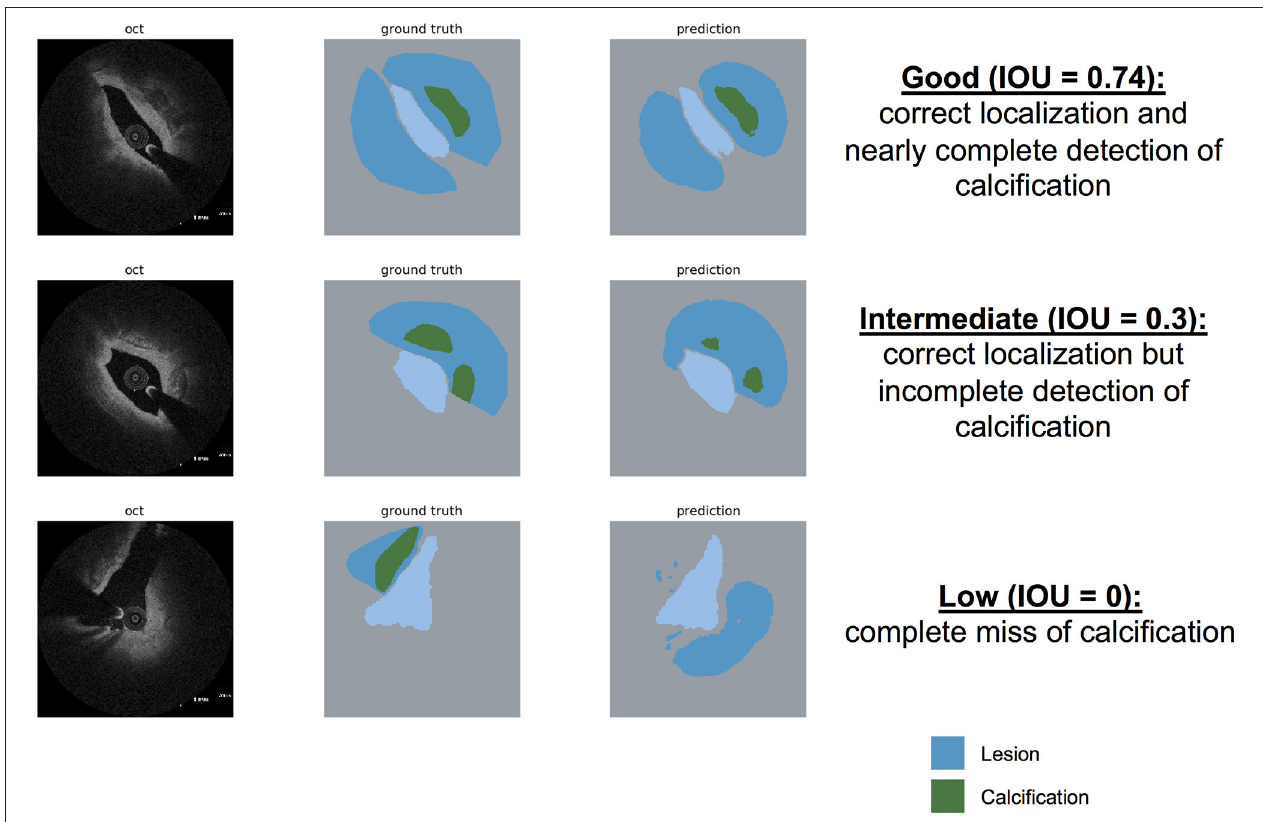
FIGURE 5 | Prediction of calcification by DeepAD. Examples for “good” (upper row) , “intermediate” (middle row) , and “low” (lower row) prediction of calcification using DeepAD (dark blue = lesion, green = calcification, light blue = lumen). Note that with an average IOU = 0.34, most calcification is localized correctly, however with incomplete